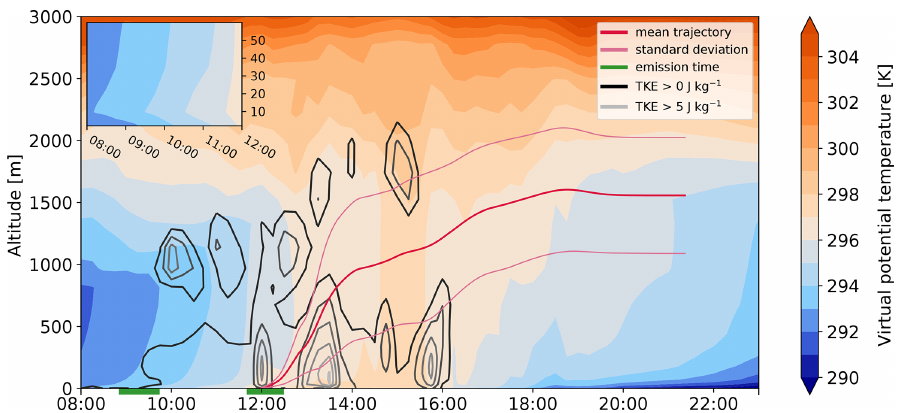
Figure 6. Atmospheric conditions for the particle dispersion. Cross section of the virtual potential temperature and TKE along the mean particle position of both